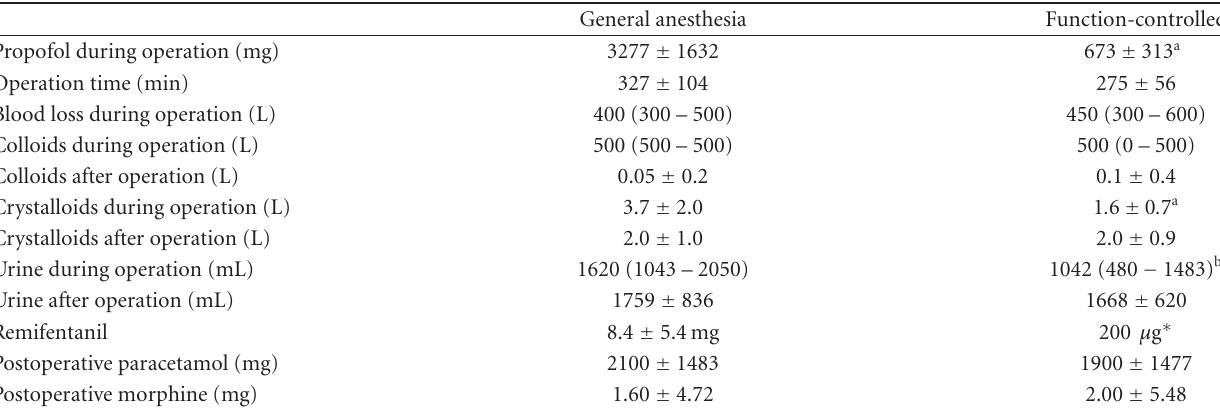
Table 2: Perioperative characteristics. General